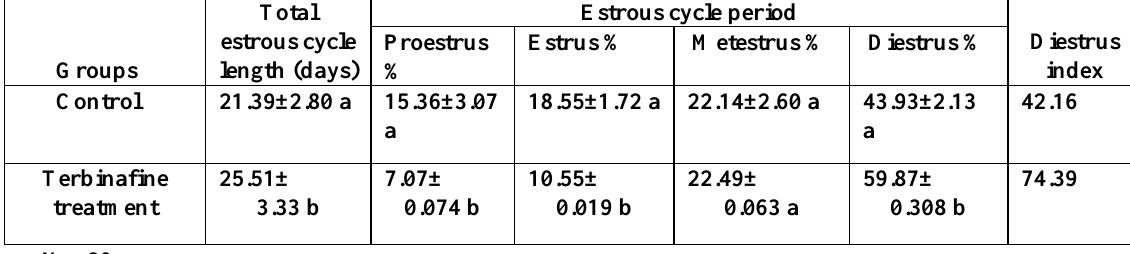
N = 20 ewe Values presented as mean ± standard error Letters: (P < 0.05) vs. differences between treatment and control